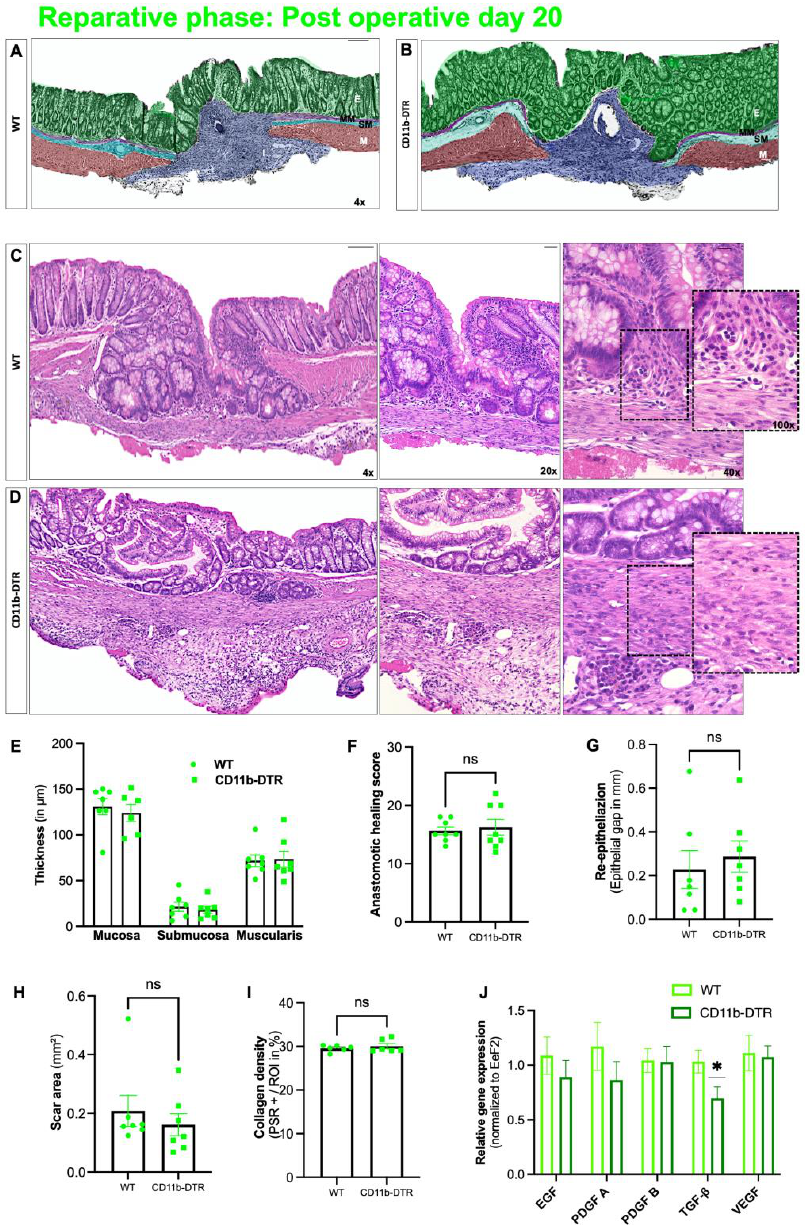
Figure 8. Intestinal anastomotic healing during the reparative phase. Multicolor stained sections of anastomotic healing (AH) at postoperative day 20 in ( A ) wild type (WT) and ( B ) CD11b-diphtheria toxin receptor (DTR) mice. E = epithelium (green); MM = muscularis mucosae (purple); SM =